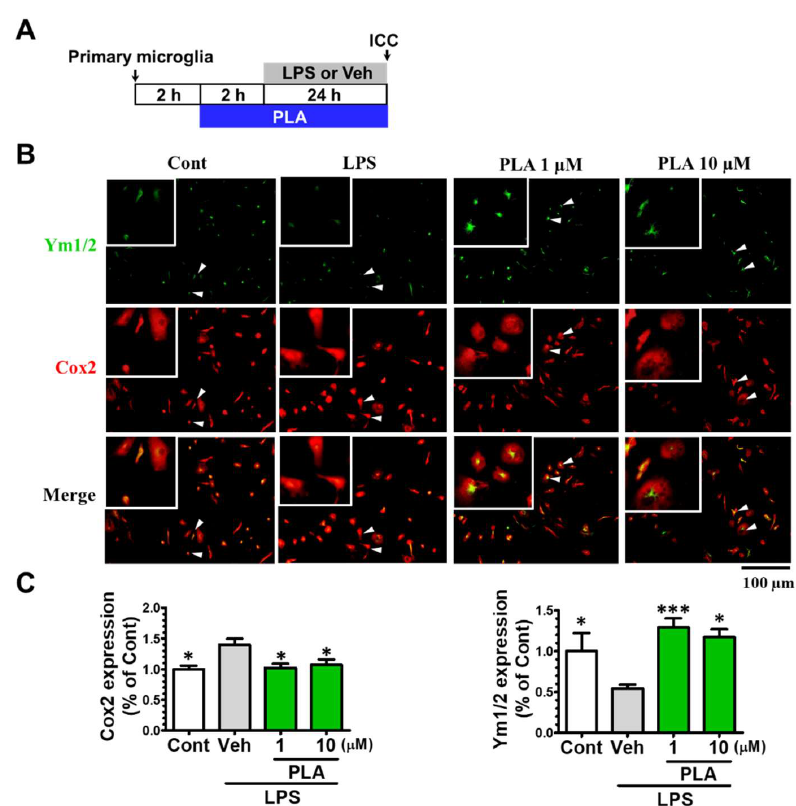
Figure 3. Effects of platycodigenin (PLA) on LPS-induced primary microglial polarization. Primary microglia were cultured for 2 h and pretreated with PLA (1 and 10 μM) or control (Cont, 0.1% DMSO) for another 2 h, followed by stimulation with LPS (100 ng/mL) for 24 h. The expression of Cox2 and Ym1/2 were determined by immunocytochemistry. ( A ) Experimental schedule. ( B ) The representative images immunostained for M1 microglia (Cox2 [red]) and M2 microglia (Ym1/2 [green]). ( C ) Cox2 and Ym1/2 expression per cell were quantified. The data are normalized to the control and shown as the mean ± SEM of three independent experiments. Ten images were captured of each group in the independent experiment. * p < 0.05 and *** p < 0.001 versus vehicle (Veh), Kruskal-Wallis one-way analysis of variance by ranks test.